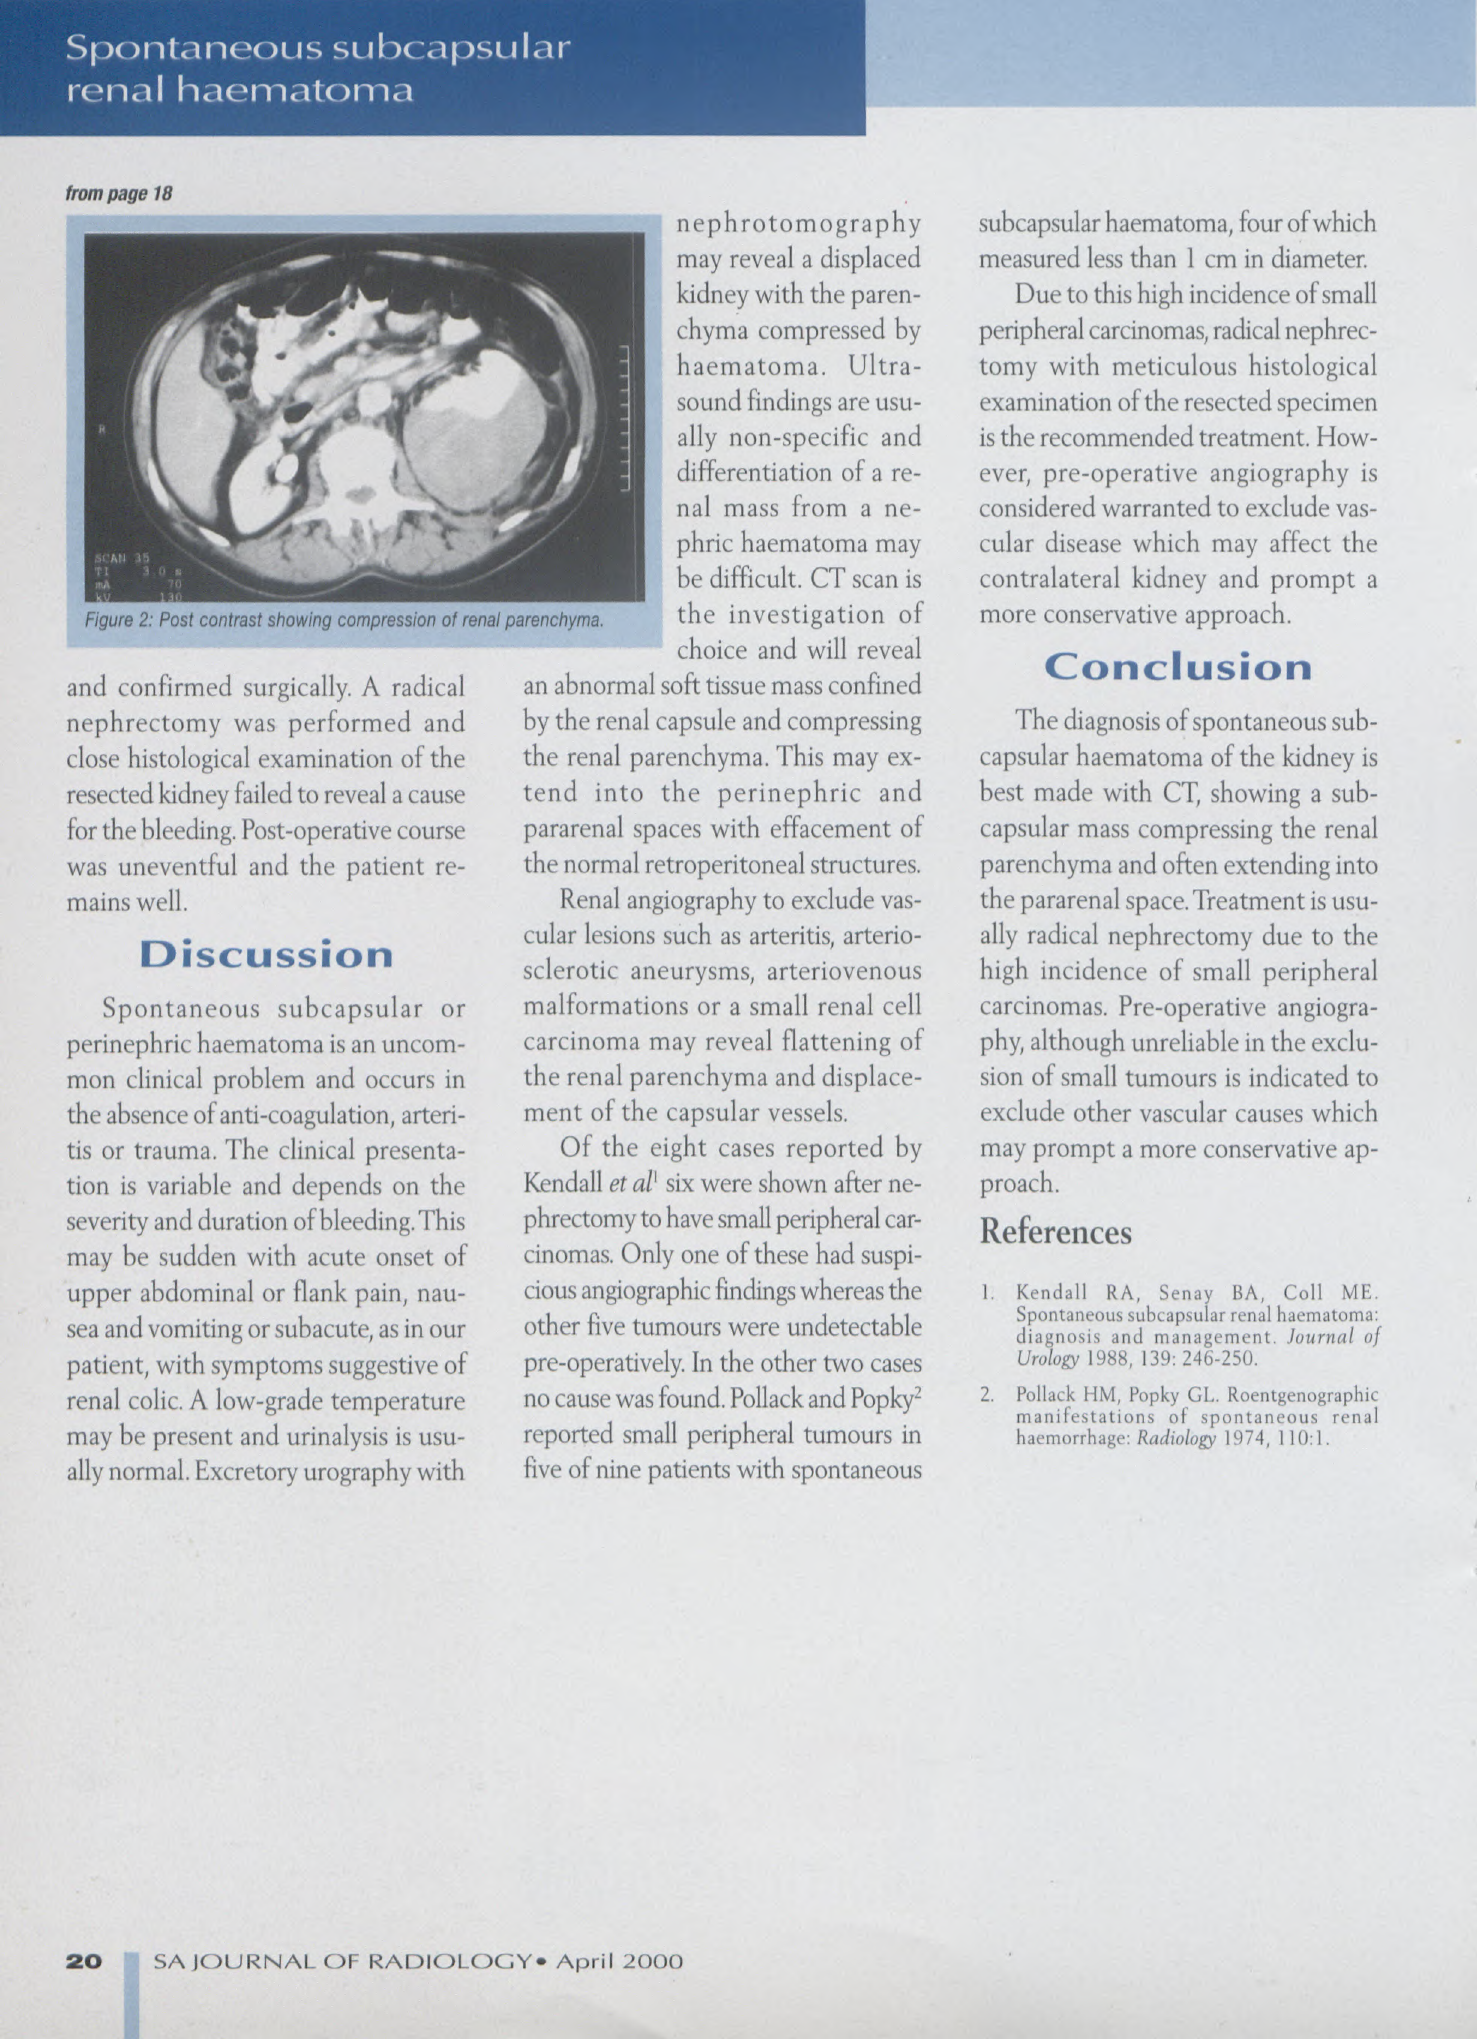
Figure 2: Post contrast showing compression of renal